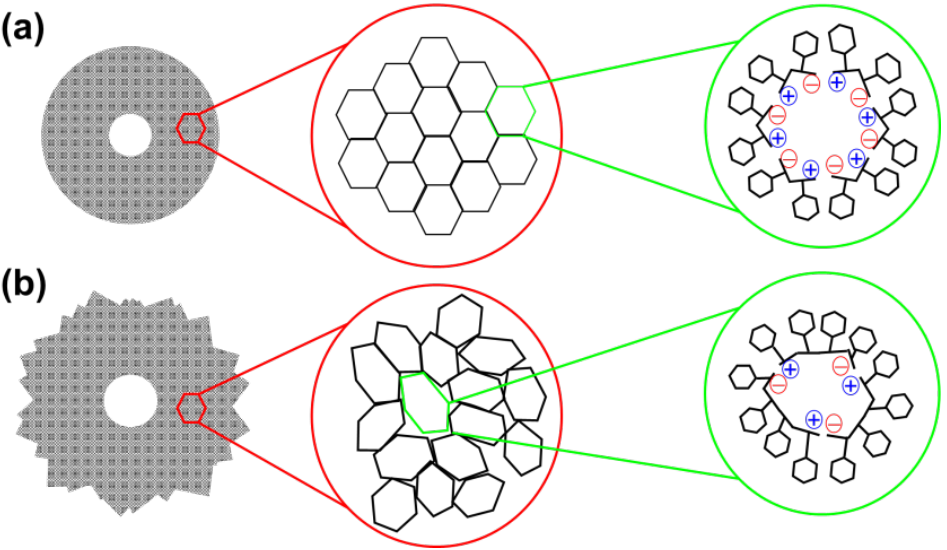
Figure 4. Sketch of the hexagonal and pseudo-hexagonal self-assembly of ( a ) FF and ( b ) FFFF, respectively. The increase of the conformational flexibility and the reduction in the density of head-to-tail electrostatic interactions led to the apparition of surface defects in FFFF.